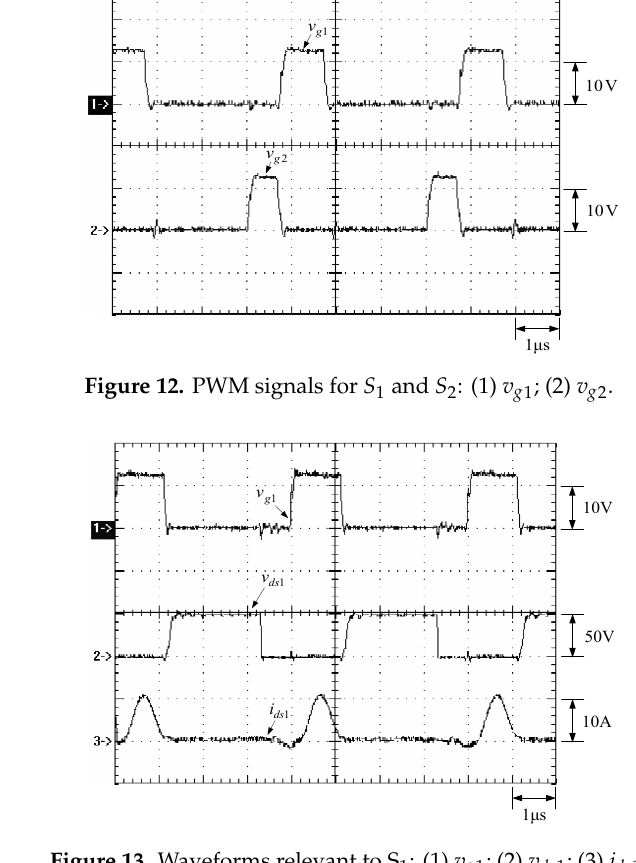
2 ds i Figure 14. Waveforms relevant to S 2 : (1) v g 2 ; (2) v ds 2 ; (3) i ds 2 . μs1